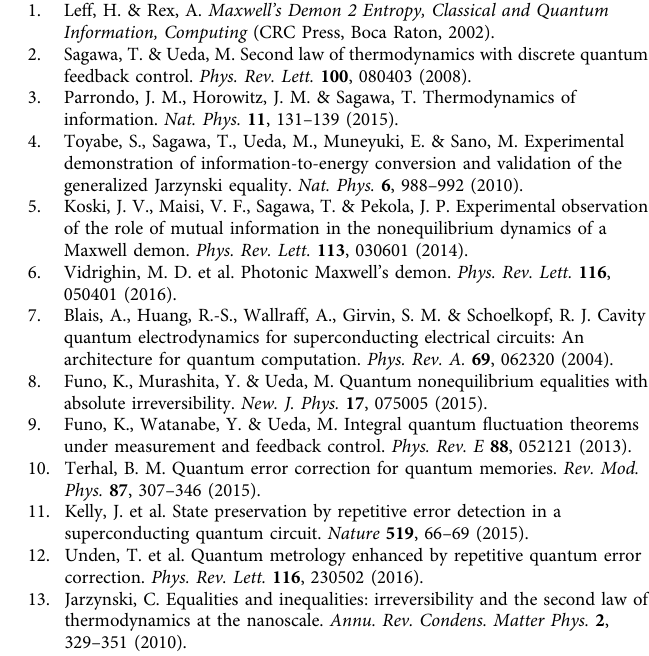
Figure 3b plots the statistical averages, e β W (cid:1) I QC